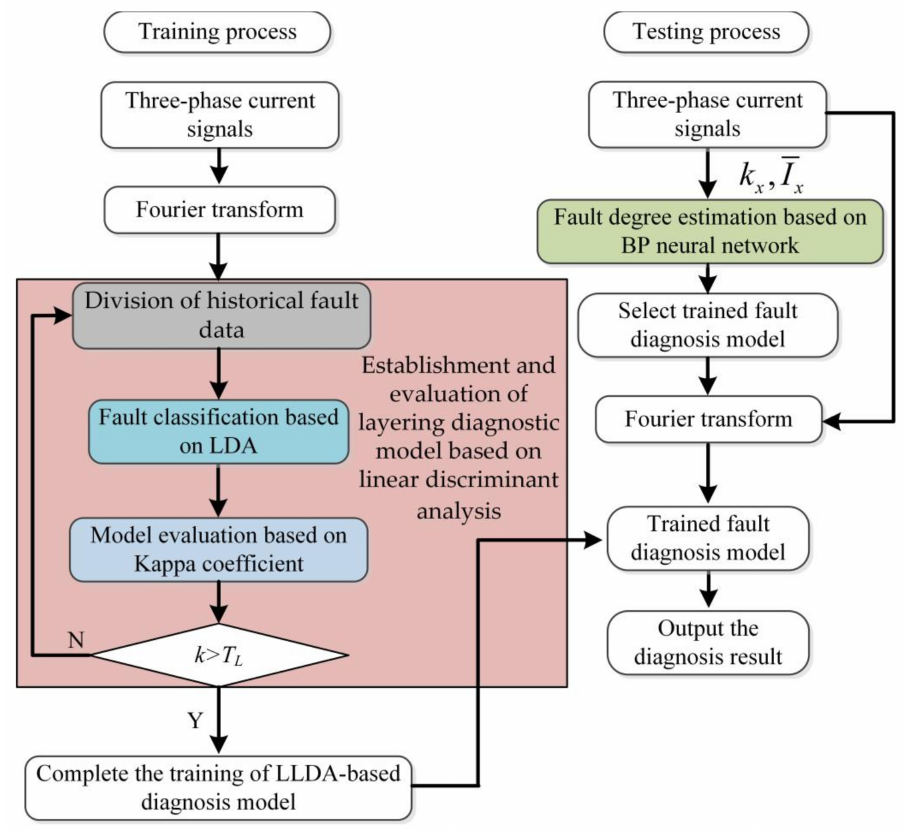
Figure 6. Flow chart of the LLDA-based fault diagnosis method for the grid-connected